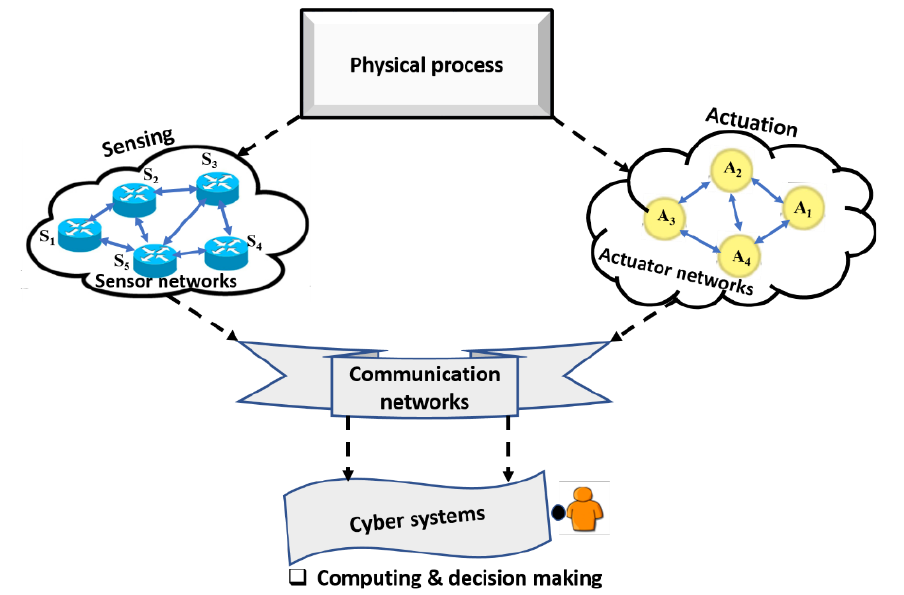
Figure 4. A simple view of CPS architecture [16].